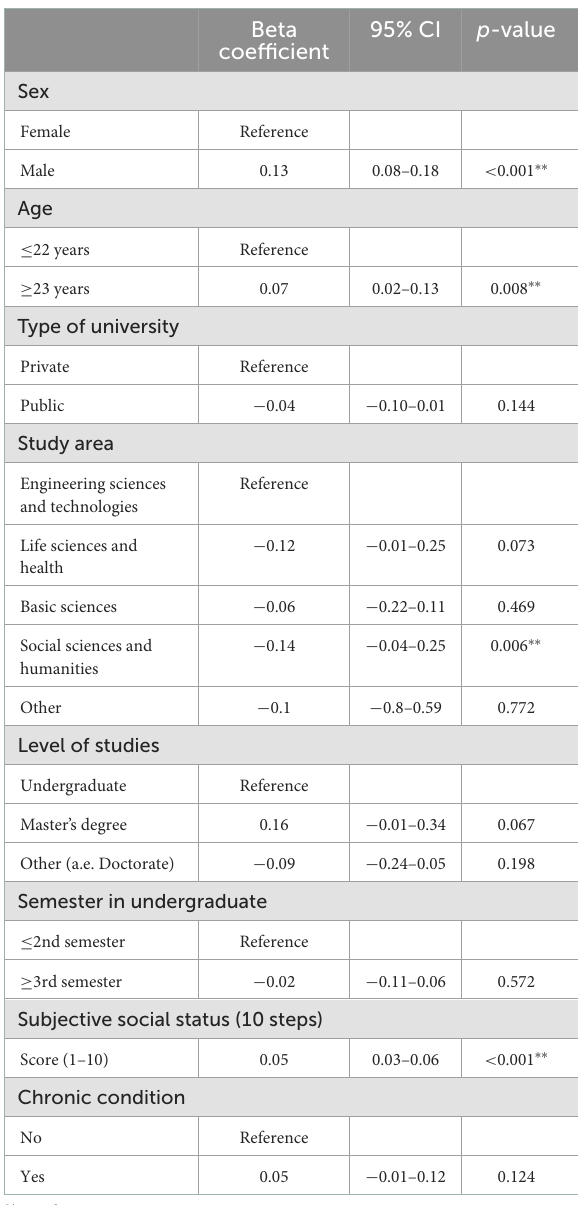
TABLE 3 Digital health literacy and characteristics of university